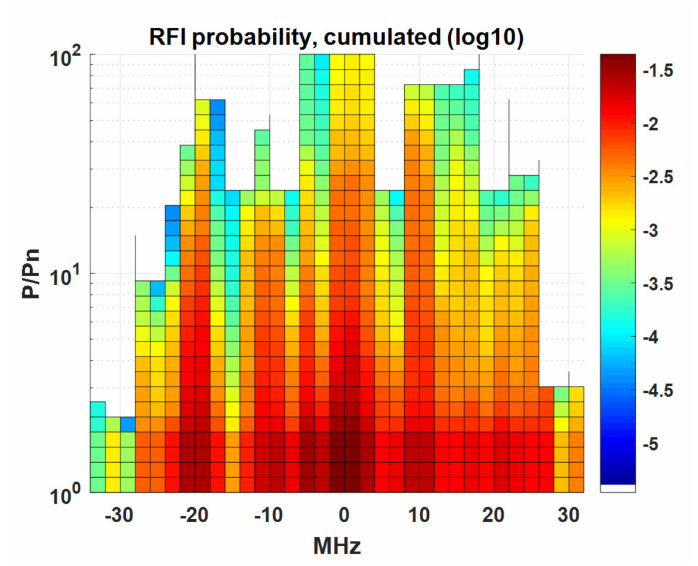
Figure 11. Cumulated histograms of RFI power distributions with frequency, normalized to S1 noise power, estimated by processing data from all-Europe. Vertical scale is probability in log 10